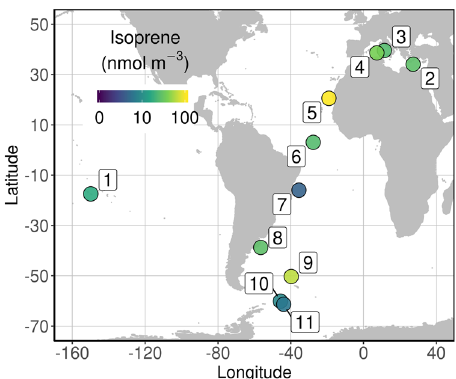
Fig. 2 Geographical distribution of the offshore experiments. Location of the sampling and incubation sites are shown by circles, coloured for isoprene